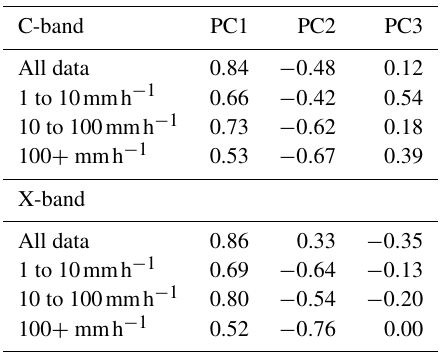
Table 3. Correlation coefficients between R and each